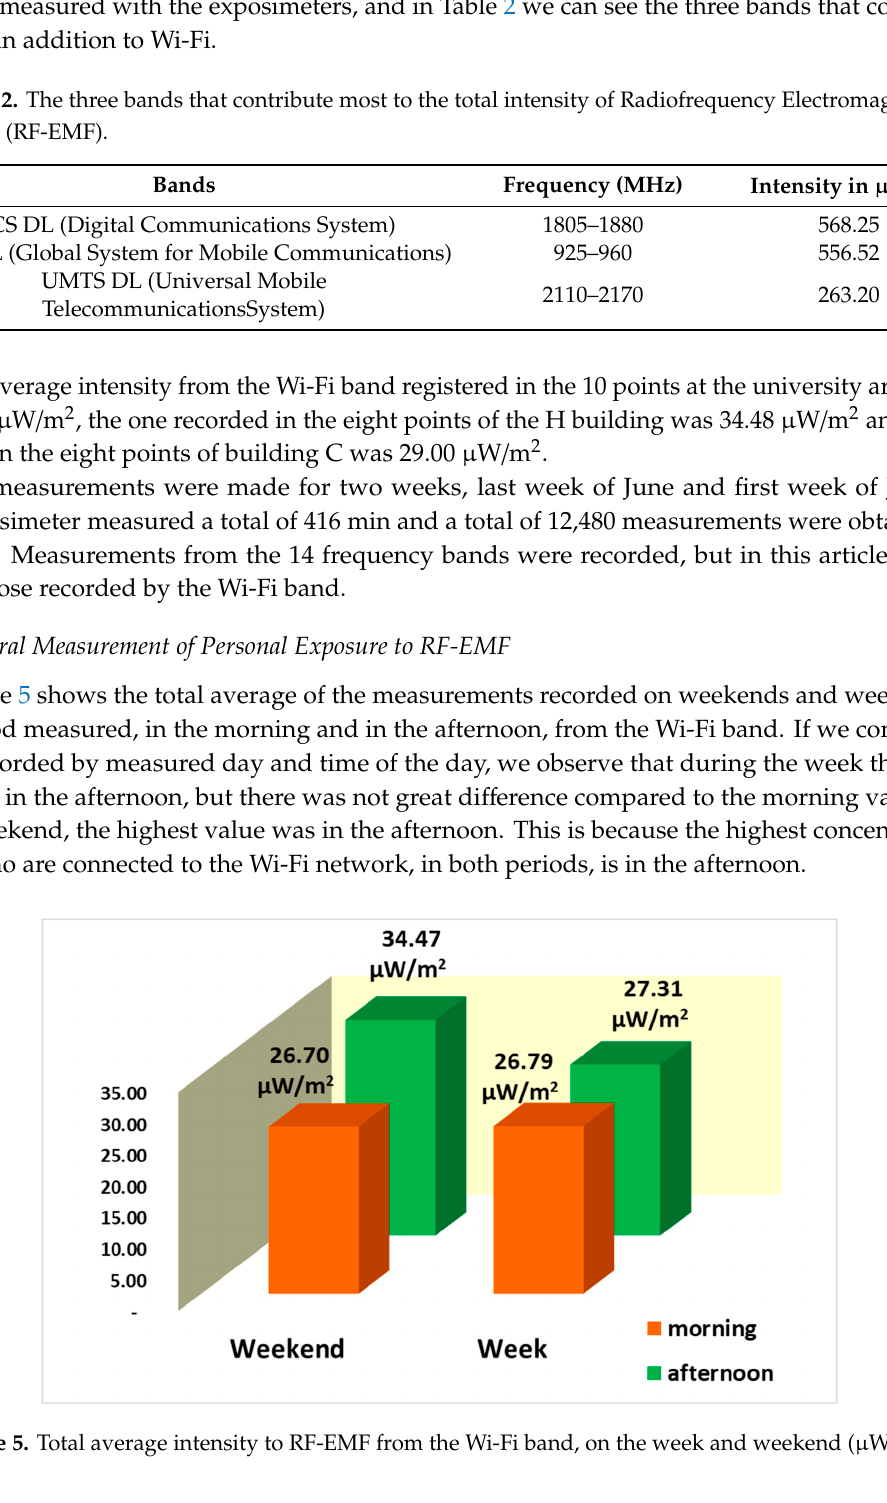
Table 1. Intensity from Wi-Fi band and the total exposure from the 14 bands. Table 2. The three bands that contribute most to the total intensity of Radiofrequency Electromagnetic Fields (RF-EMF).